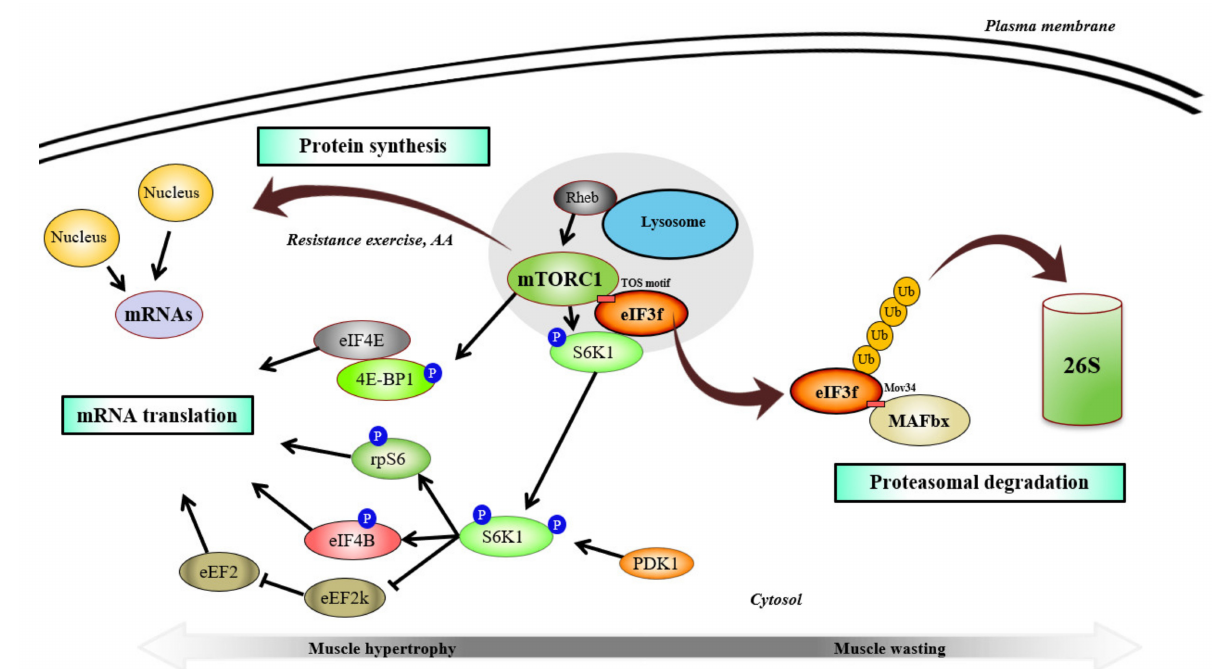
Figure 3. mTORC1 regulates eIF3f in skeletal muscle protein translation. RHEB (Ras homolog enriched in brain) activates mTORC1 (mechanistic/mammalian target of rapamycin complex 1), which binds to the scaffold protein eIF3f (eukaryotic initiation factor 3f ) through a TOS (TOR signaling) motif and modulates mRNA translation by phosphorylating eIF3f bound- S6K1 (S6 kinase 1) and 4E-BP1 (eukaryotic translation initiation factor 4E-binding protein 1). S6K1-mediated regulation of translation occurs, in part, through phosphorylation of rpS6 (ribosomal protein S6), eIF4B (eukaryotic translation initiation factor 4B), and eEF2k (eukaryotic elongation factor-2 kinase). eEF2k inhibits eEF2 (eukaryotic elongation factor-2) to promotes mRNA translation. Phosphorylation of 4E-BP1 by mTOR (mechanistic/mammalian target of rapamycin) promotes its dissociation from eIF4E (eukaryotic initiation factor 4E) and allows for the assembly of the preinitiation complex. During muscle wasting, eIF3f is targeted by MAFbx (muscle atrophy F-box) at Mov34 motif to promote eIF3f proteasomal degradation. Resistance training and amino acids enable the migration of the mTORC1/eIF3f complex at the lysosome surface and at the cell membrane near to peripheral nuclei and blood capillaries. Of note, PDK1 (phosphoinositide- dependent kinase-1) phosphorylates S6K1 for full